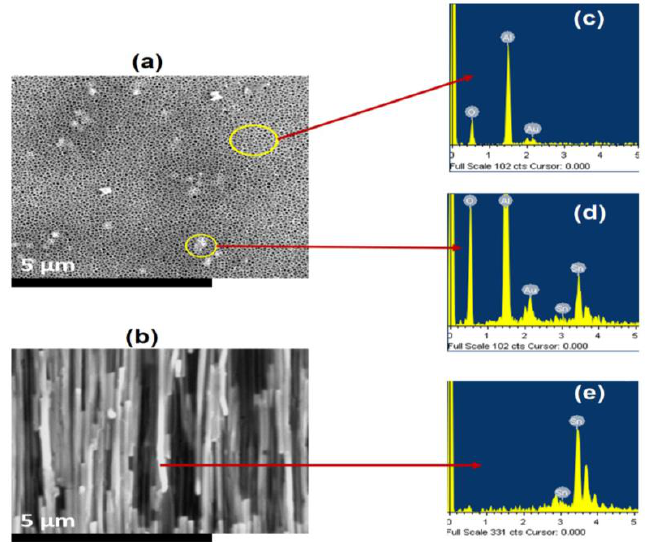
Figure 4. Energy dispersive X-ray spectrometer (EDS) Spectrum of Sn nanostructures array ( a ) secondary electron (SE) image of the top view of the template before etching, ( b ) SE image of the side view of the nanostructure after template etching, ( c ) EDS spectrum with anodic aluminium oxide (AAO) template with empty pores before etching, ( d ) EDS spectrum of the AAO template where the pores were filled before etching, ( e ) EDS spectrum of the nanostructure after template etching.